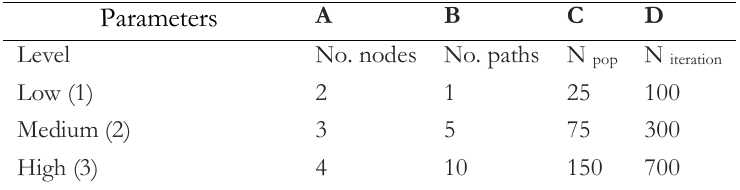
Table 12. Orthogonal array.